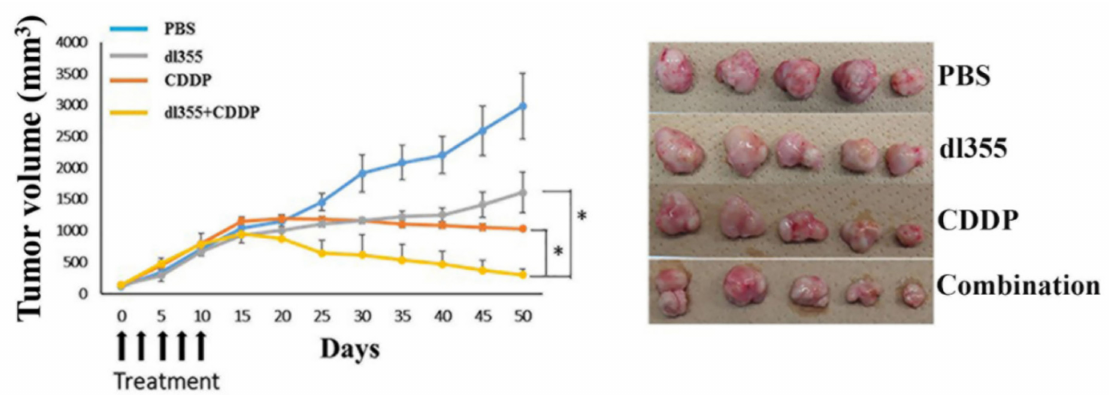
Figure 5. Evaluation of the therapeutic potential of combined therapy in vivo. The subcutaneous cervical xenograft model was developed based on HeLa S3 cell implantation. Treatments were as follows: PBS (control), dl355, CDDP, and combination. CDDP (intraperitoneal) and dl355 (intratumoral) injection was administered. We measured tumor volume at di ff erent time points after treatment. The image showed the di ff erences in tumor volume on day 40 post-treatment when the mice were sacrificed. * indicates p < 0.05.